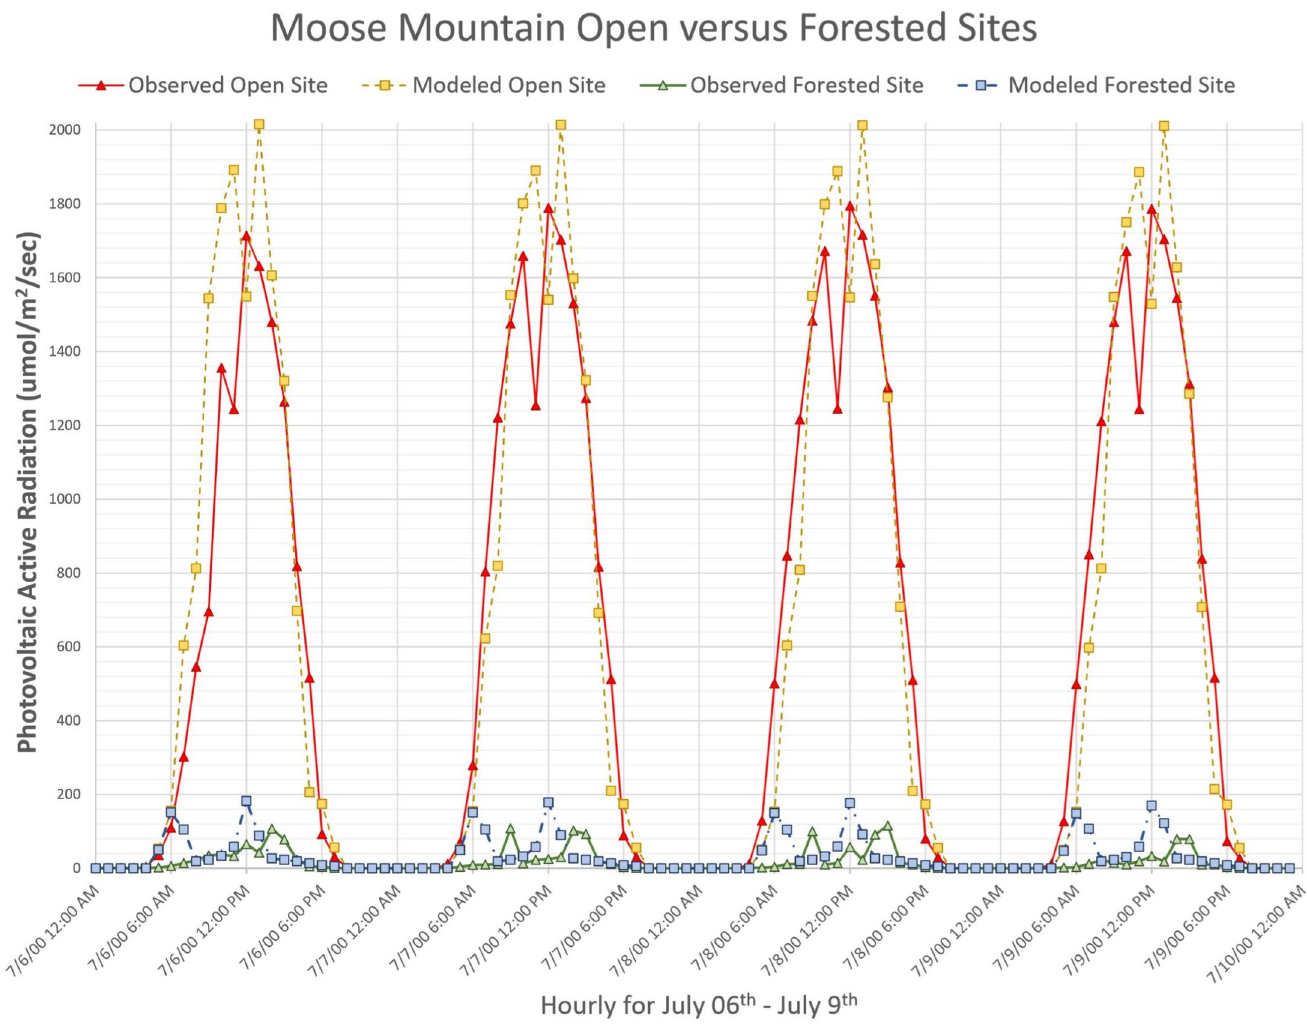
Fig 6. Moose Mountain open-site versus forested-site. These plotted data represent simulated versus observed PAR ( μ moles/m 2 /s) for the O’CCMoN Moose Mountain open-site and forested-site. Note the magnitude of solar energy difference between the open versus forested